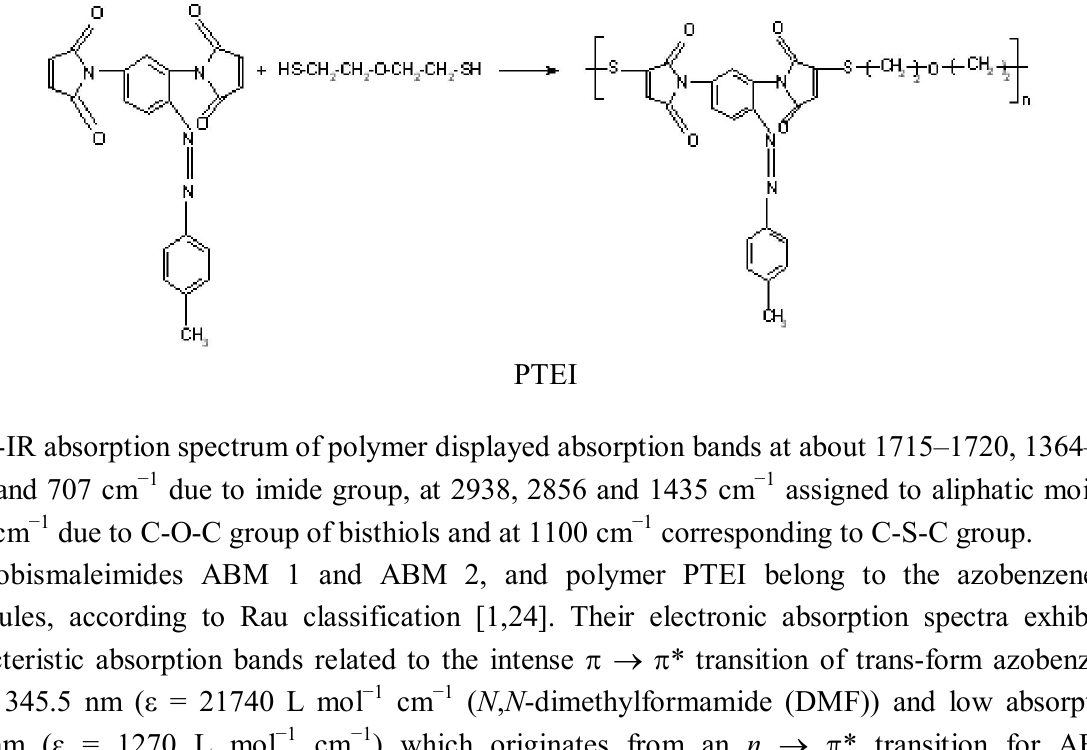
Figure 1. 1 H NMR spectrum of azobismaleimide ABM 2 in CDCl